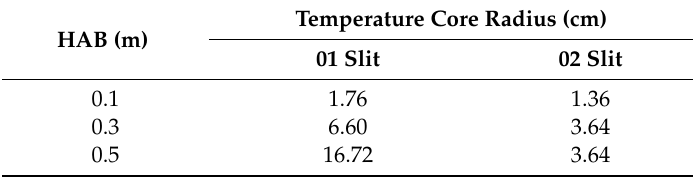
Table 1. Temperature core radius at three monitoring HABs: 01 slit case and 02 slit case.